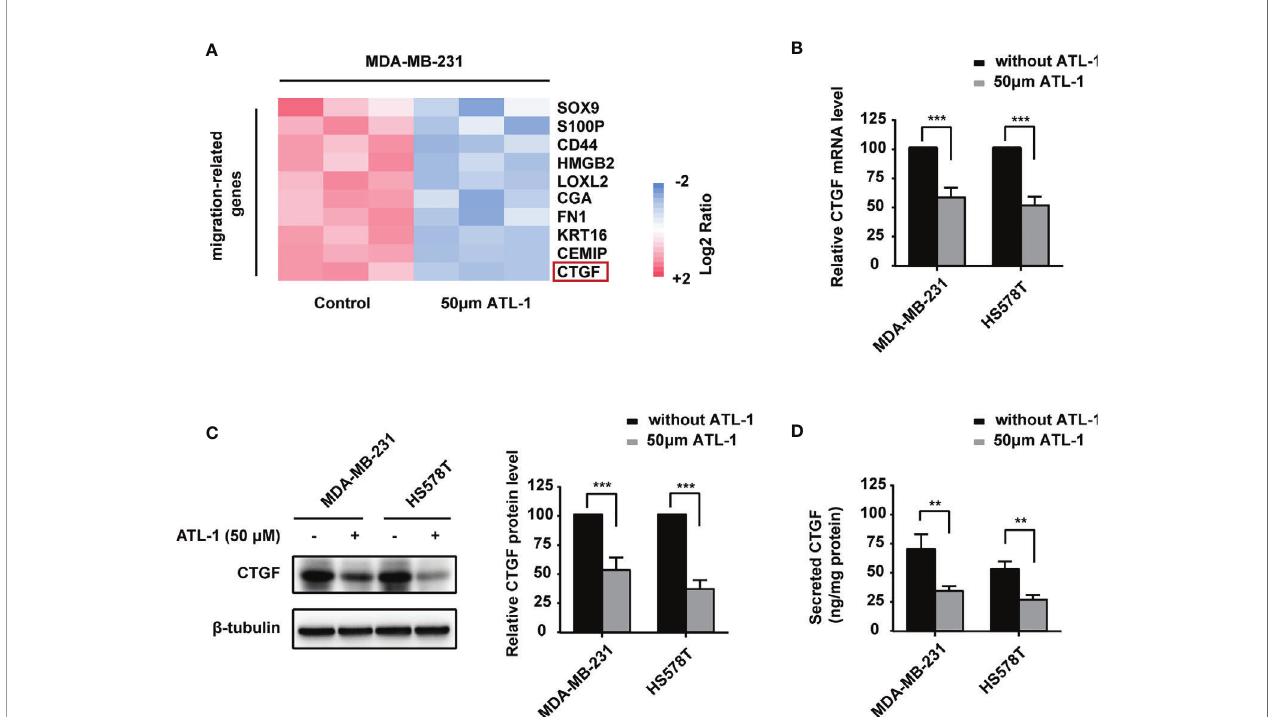
FIGURE 2 | ATL-1 downregulates CTGF expression in triple-negative breast cancer cells and inhibits cancer cell migration via CTGF. (A) Heatmaps of migration- related gene-expressions from MDA-MB-231 qRT-PCR analysis. MDA-MB-231 cells were treated with/without 50 m M ATL-1 for 24 h. Pink and blue colors represent gene expression levels above and below the mean, respectively. (B) qPCR illustrated the downregulation of CTGF mRNA in MDA-MB-231 and HS578T cells after treatment with 50 m M ATL-1 for 24 hrs. Western blotting (C) and ELISA (D) illustrated downregulation of the CTGF protein and secreted protein levels of MDA-MB-231 and HS578T cells after treatment with 50 m M ATL-1 for 24 hrs. (A – D) Three technical replicates were performed for each of the three biological replicates. Mean ± SD, **p < 0.01, ***p < 0.001 compared to without ATL-1 treatment by Student ’ s t